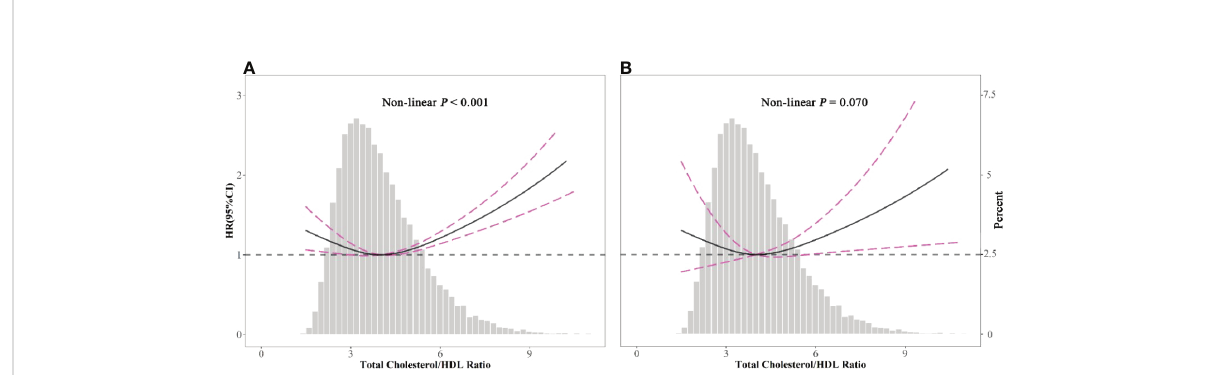
FIGURE 2 Spline analyses of all-cause (A) and cardiovascular (B) mortality by the total cholesterol/high-density lipoprotein cholesterol (TC/HDL-C) ratio in the overall cohort, and the probability distribution histogram is represented in the background. (Spline analyses were adjusted for age, gender, race, smoking, body mass index, systolic blood pressure, estimated glomerular fi ltration rate, diabetes and hypertension, antihypertensive drugs, hypoglycemic agents, and lipid-lowering drugs.).